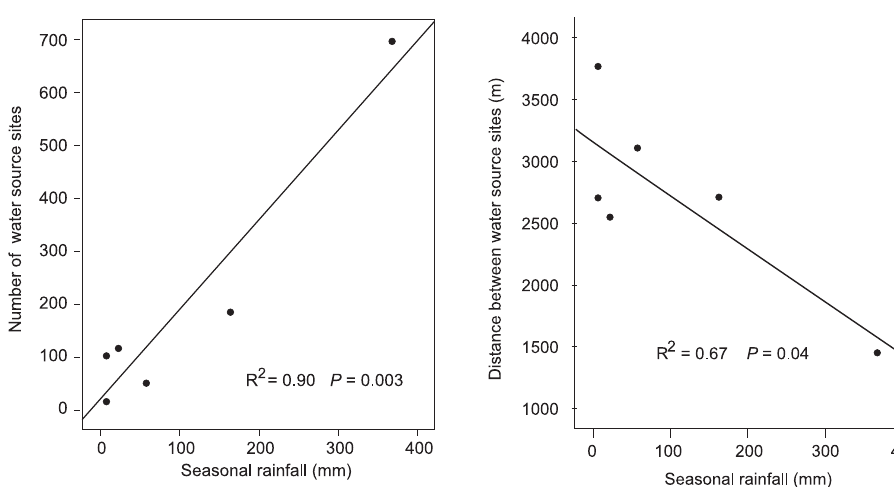
Fig. 5. The significant linear relationship between the number of water source sites and seasonal rain- fall in the Manyeleti Game Reserve.